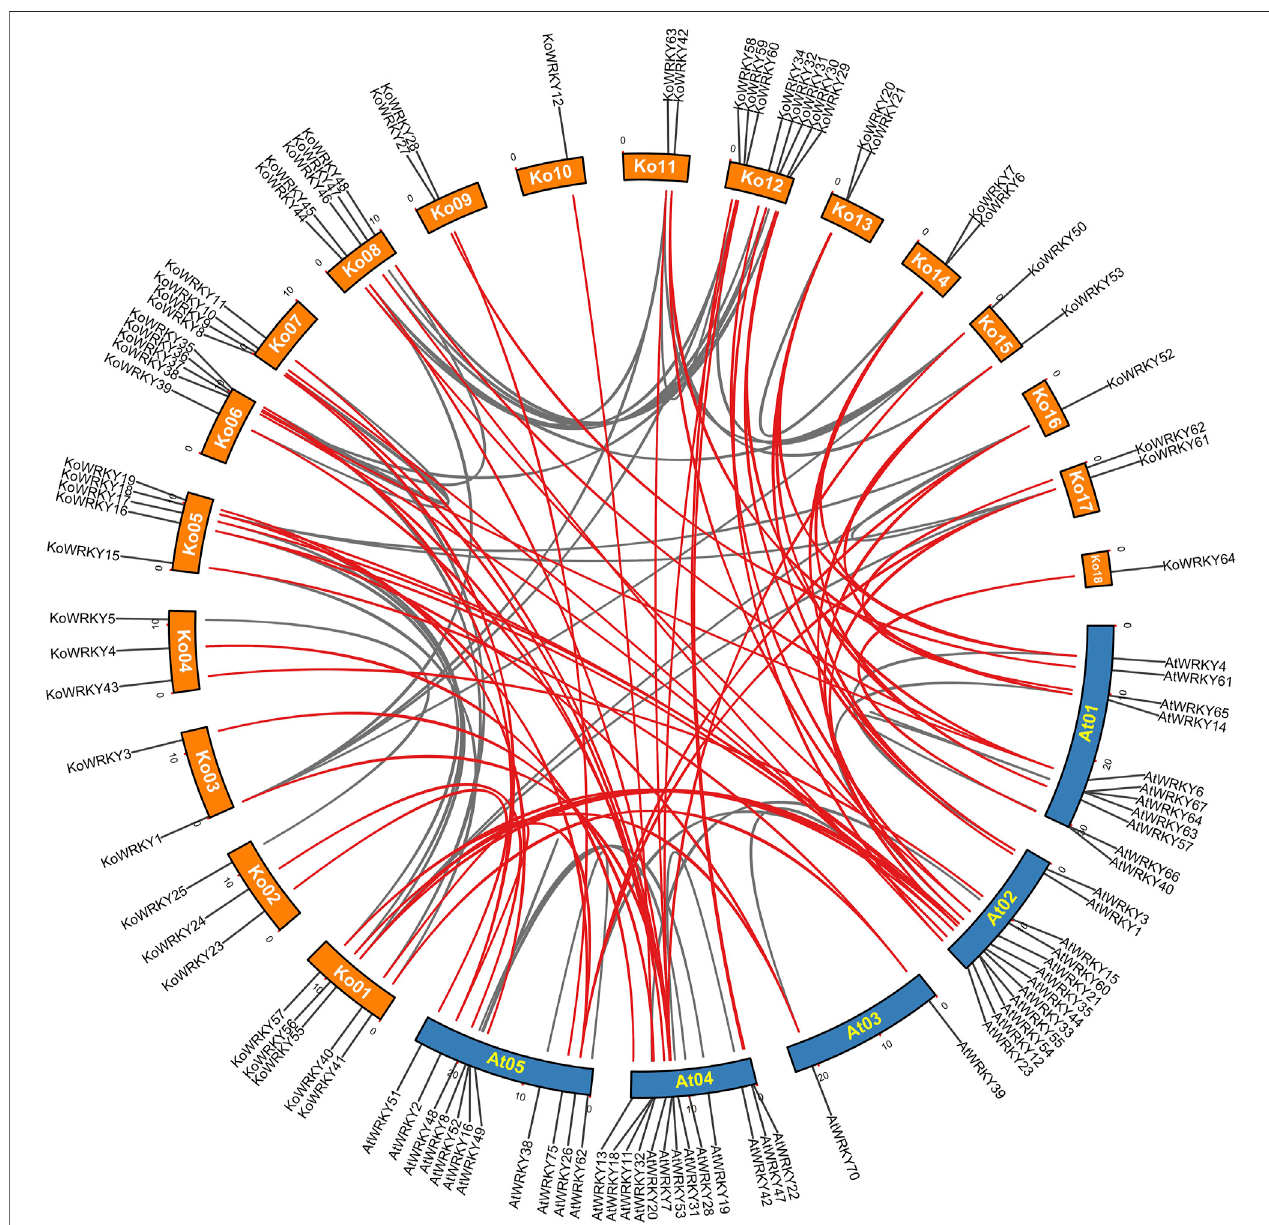
FIGURE 3 | Synteny analysis between WRKY genes of Kandelia obovata and Arabidopsis thaliana , as performed by MCScanX. The chromosome numbers of K. obovata are Ko01 – 18, and the chromosome numbers of A . thaliana are At01 – 05. The red curves indicate synteny relationships between K. obovata and A. thaliana WRKY genes, and the gray curves indicate synteny between WRKY genes within K. obovata or A . thaliana.